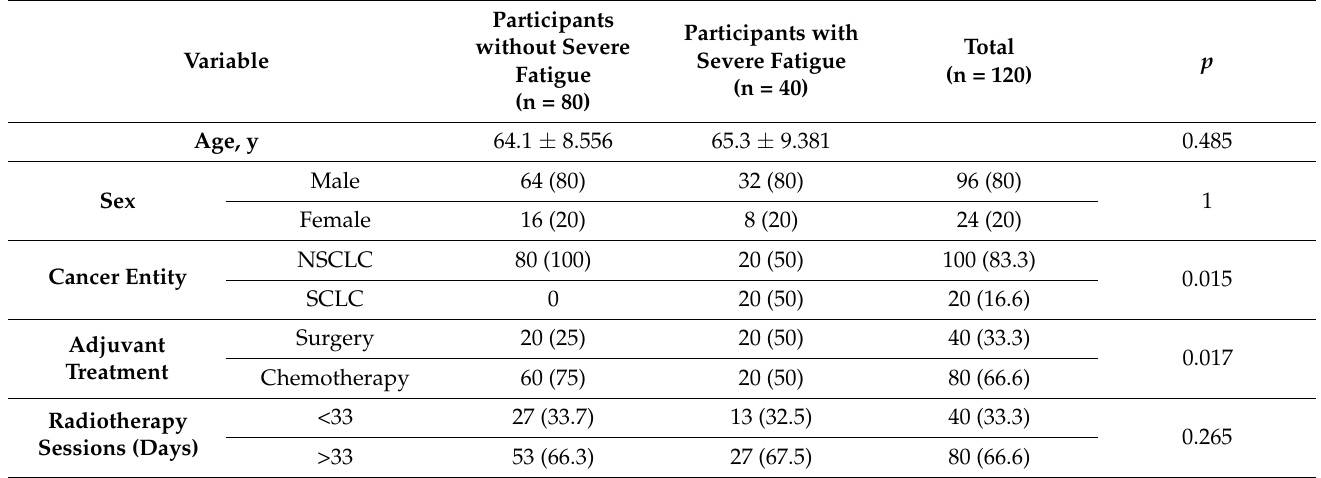
Table 1. Clinical characteristics of the included patients.